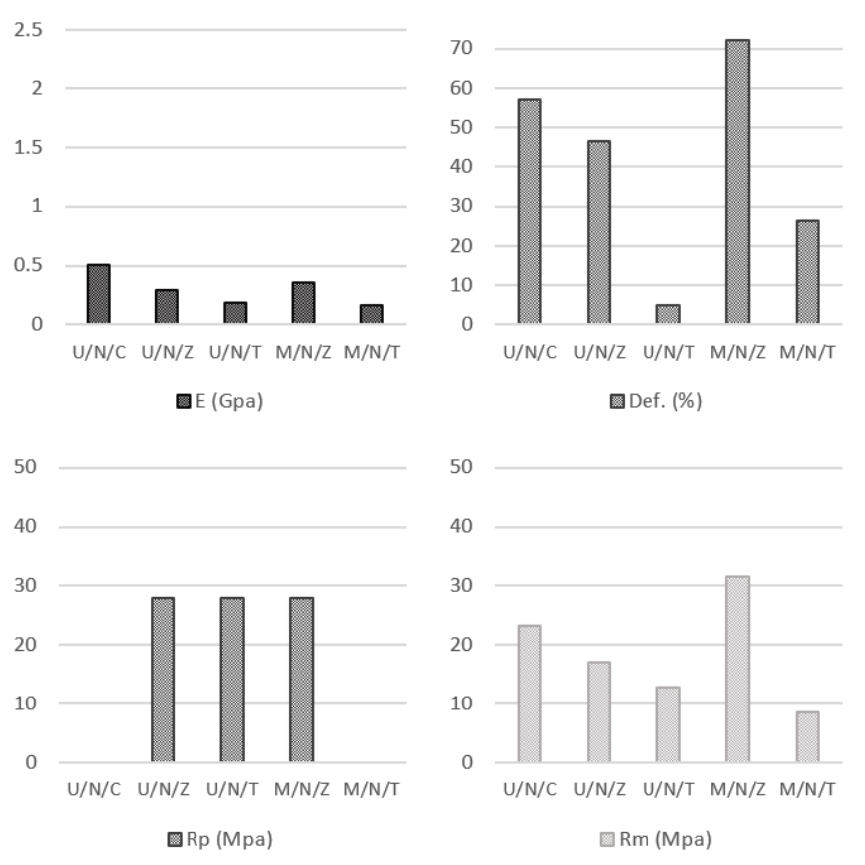
Figure 14. Nylo n specimens’ parameters average values. Figure 14. Nylon specimens’ parameters average